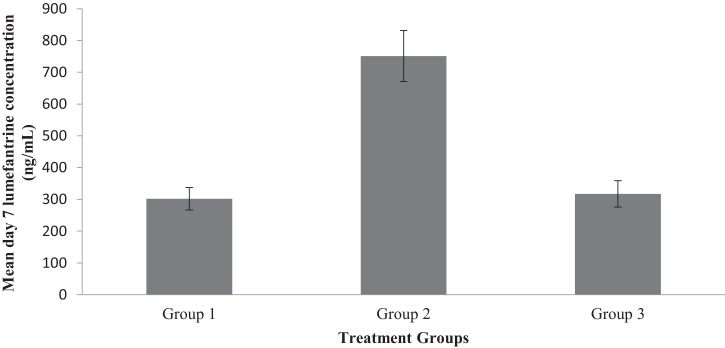
Mean day 7 lumefantrine concentration (ng/mL) in the three groups. N=15 for each group. Values are mean ± standard error of means SEM. *Mean value in Group 2 statistically significant at p < 0.05, when compared to Group 1.